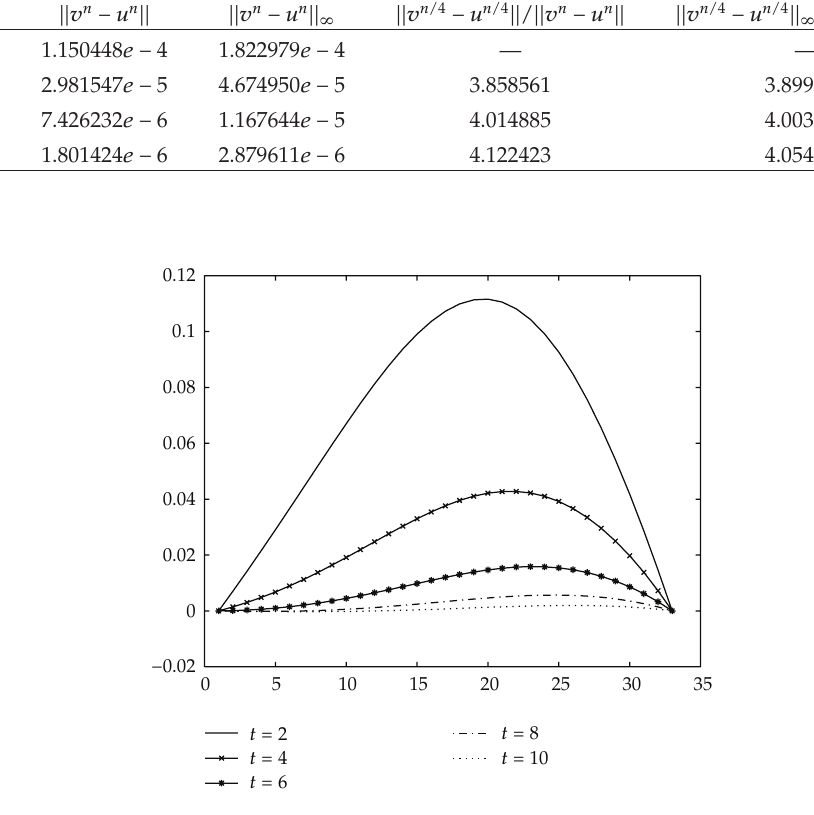
Figure 1: Numerical solution of u (cid:4) x,t (cid:5) with h (cid:9) 0 . 03125 ,τ (cid:9) 0 . 1 when p (cid:9)